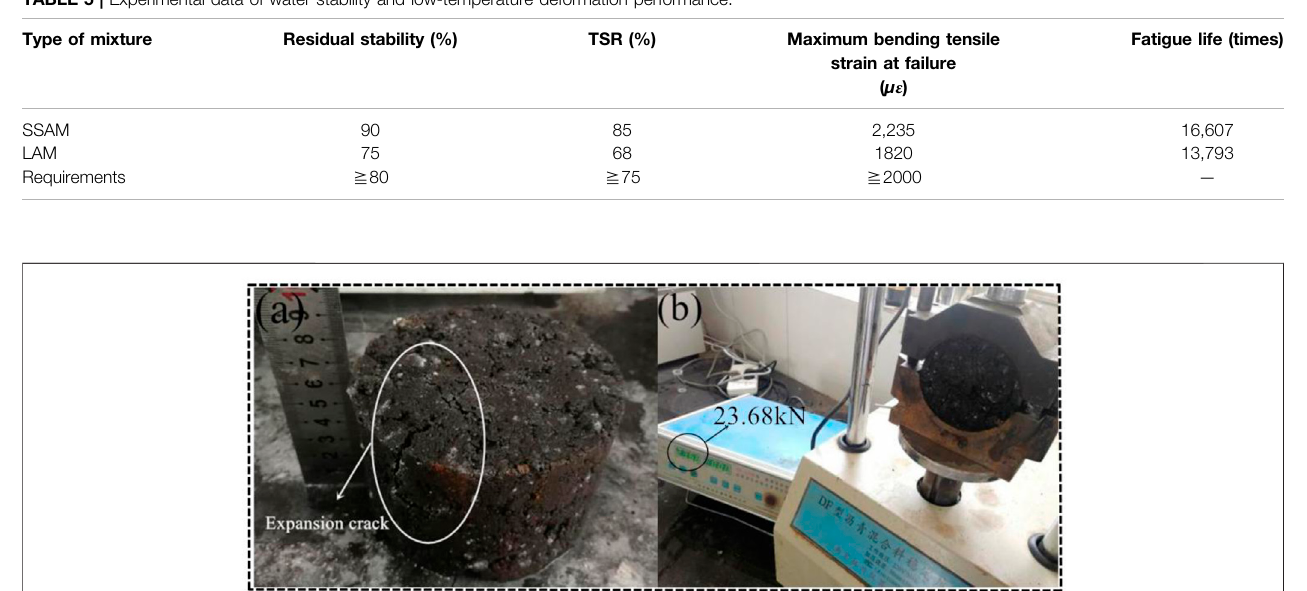
FIGURE 6 | Expansion cracking: (A) Marshall specimen after 120 days of immersion; (B) Marshall stability after 120 days of immersion.